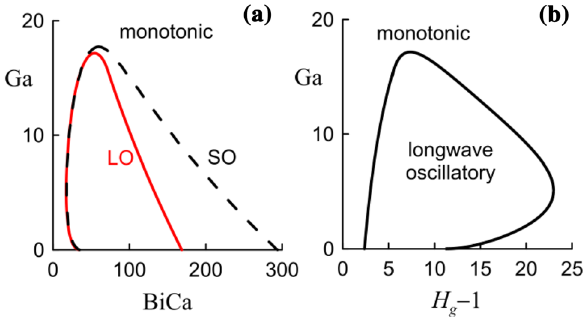
Fig. 3 a The domain of oscillatory instability for one-layer model. Solid and dashed lines correspond to results obtained within the longwave approximation (LO) and for arbitrary wavenumbers (SO), respectively. Here Pr = 1, Ca = 1000. b The domain of longwave oscil- latory mode for two-layer model for Ca = 2000, λ